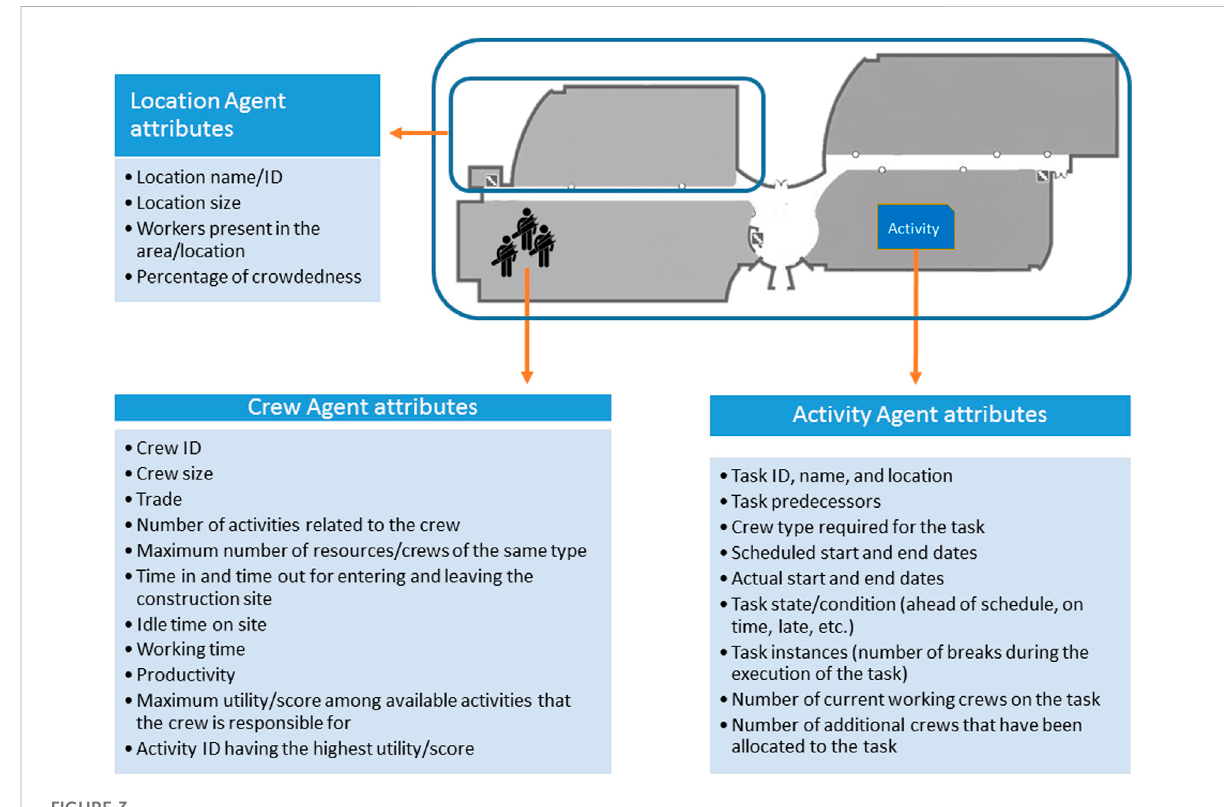
FIGURE 3 Main environment and the agents along with their